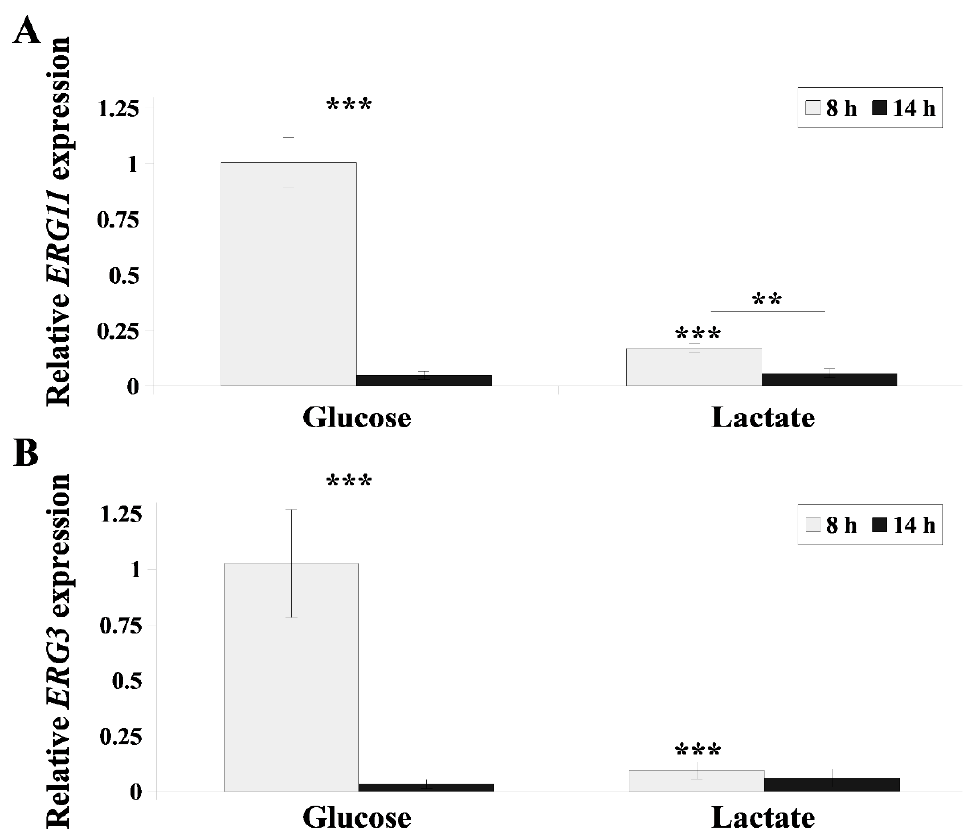
Figure 5. Relative ERG11 ( A ) or ERG3 ( B ) gene expression in C. albicans during different growth phases (8 h (grey) and 14 h (black)) in YPD or YPL medium. Gene expression levels as means of 2 −ΔΔ CT values ( n = 6) ± SD, normalized to 1 for 8 h YPD-grown gene expression level. Statistical analysis compared data during different growth phases (above lines) or compared YPD- and YPL-grown strains (above bars) (**, p < 0.01; ***, p < 0.001). Table 2. Sterols ( µ g/mg dry mass of isolated lipids, means ± SD, n = 3) in C. albicans CAF2-1 grown in YPD (glucose) or YPL (lactate) for 8 or 14 h. ND—not detected. Statistical analysis was performed in accordance with µ g/mg values after 8 h of glucose culture (** p < 0.01; *** p <